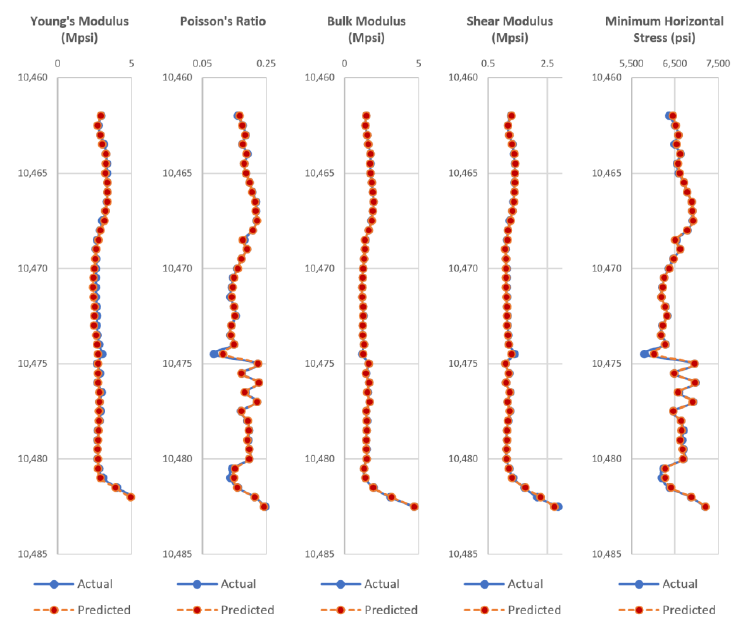
Figure A8. Actual and predicted geomechanical properties along with depth (feet) for test well 4 in Williams County for the Middle Bakken Formation.